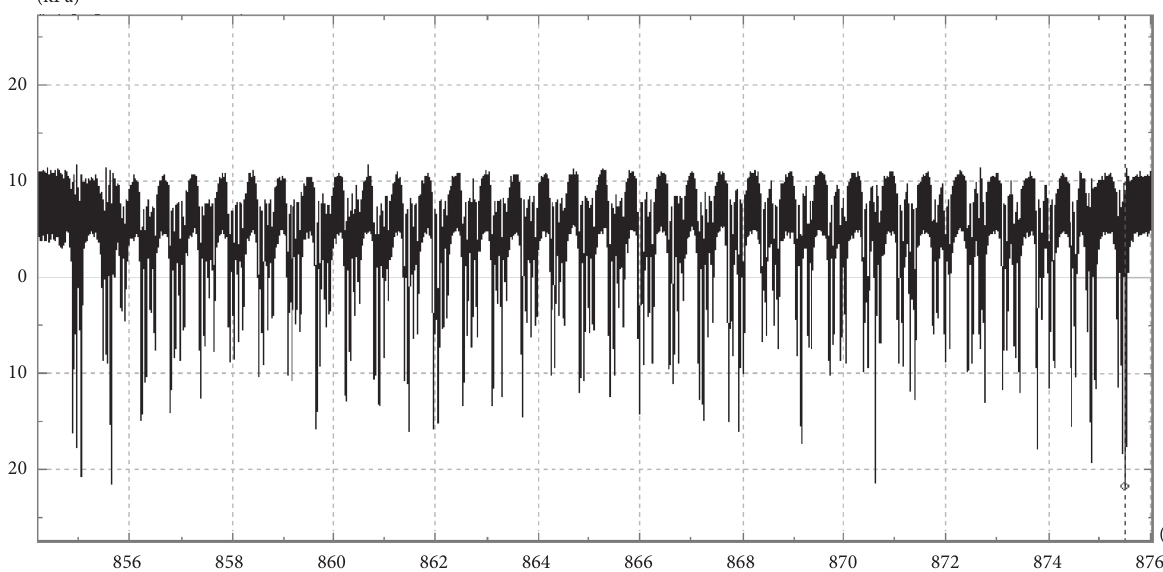
Figure 9: Vertical dynamic stress of the top surface of the invert filling layer in the intact zone.